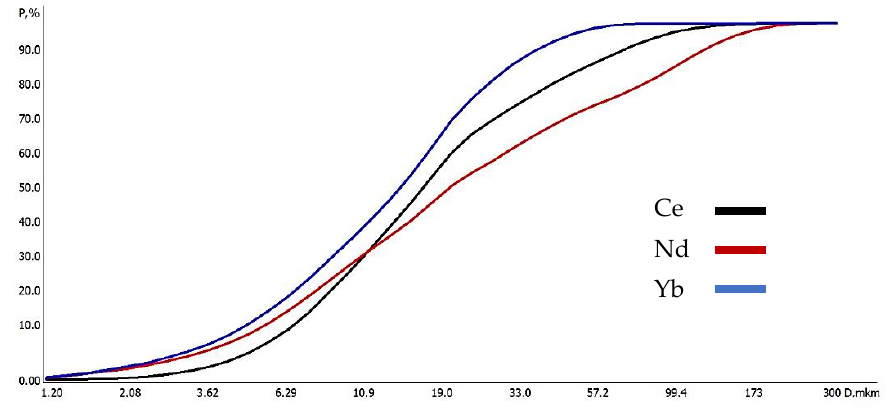
Figure 1. Granulometry of powders. The dimensions of the fractions are shown in Table 2. Table 2. Size of fractions. Element P, % Ce